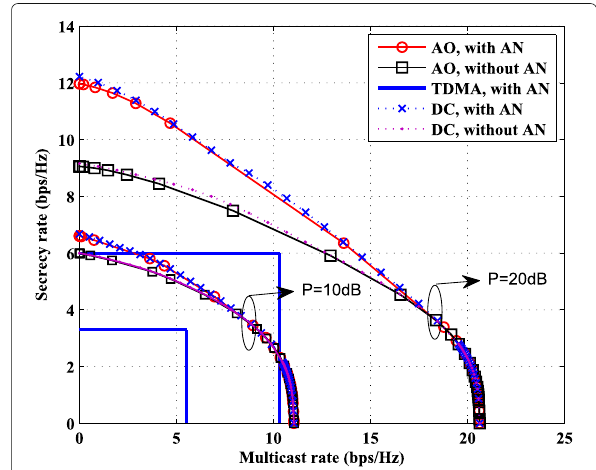
Fig. 4 Secrecy rate regions with and without AN (Config 1)